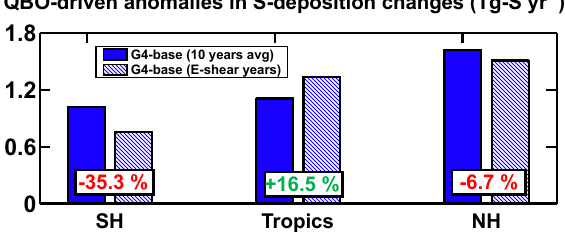
Figure 14. QBO-driven anomalies of S-deposition changes (TgSyr − 1 ) in the tropical region (25 ◦ S–25 ◦ N) and in the two ex- tratropical regions, i.e., 90–25 ◦ S and 25–90 ◦ N. The colored blue bars represent the S-deposition changes in the ULAQ-CCM aver- aged over the full decade 2030–2039. The striped blue bars repre- sent the S-deposition changes calculated only under E shear con- dition. The numbers in the boxes show the percent changes in the S-deposition changes due to SG under E shear conditions with re- spect to the one calculated over the full decade, i.e., under both QBO